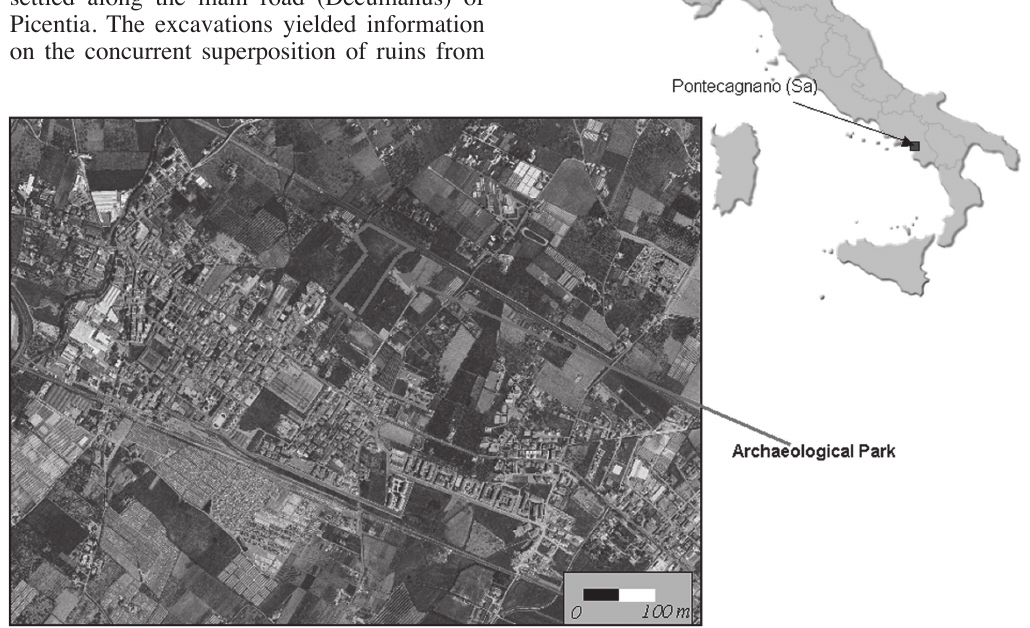
Fig. 1. The site of the Pontecagnano-Faiano Archaeological Park, near Salerno in Southern